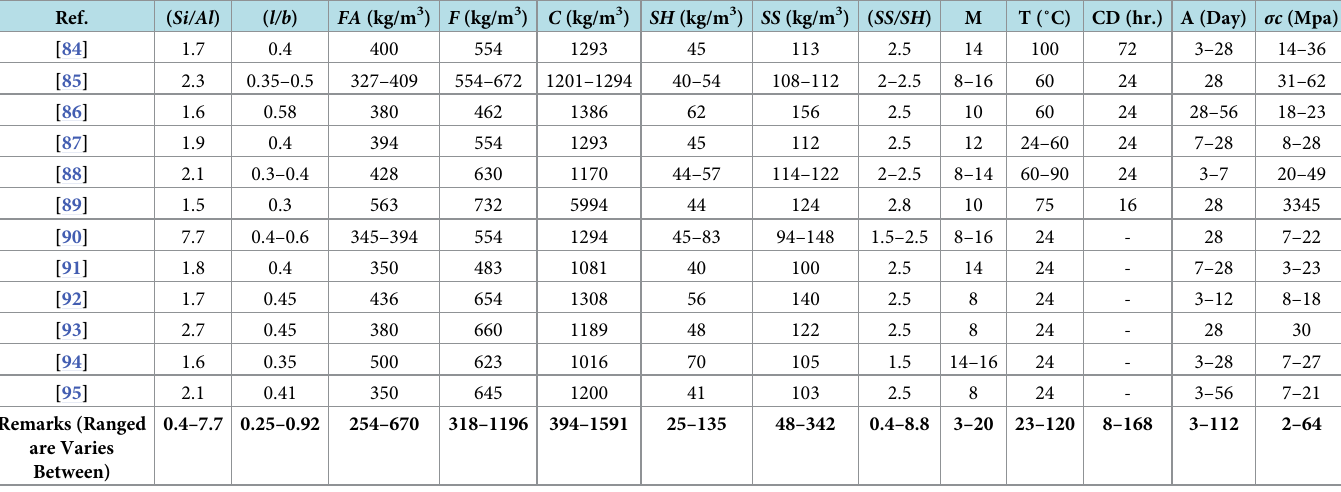
in a symmetrical normal distribution in a dataset. If the curve is moved to the right or the left side, it is stated to be skewed. Also, skewness could be quantified as an impersonation of the range to which a given distribution differs from a normal distribution. For instance, the skew of zero value was measured for normal distribution, while, right skew is an indication of log- normal distribution [97]. The variation between compressive strength and Si/Al, as well as the histogram analysis, is shown in Fig 2. As can be seen from figure a very poor relationship existed between compressive strength and the Si/Al